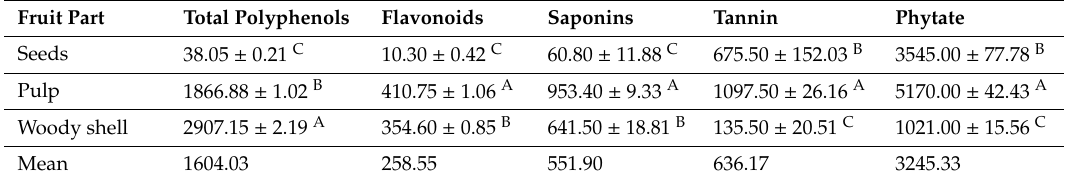
Table 2. Phytochemical composition (mg / 100 g) of dry fruit of prekese [47].